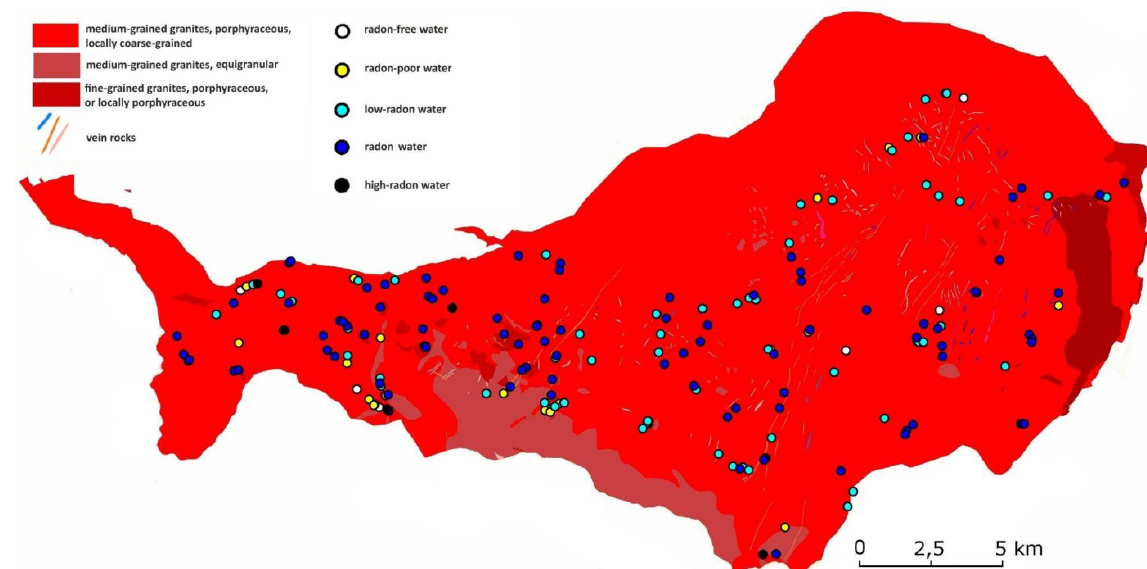
Figure 2. The Karkonosze granites. Groundwater sampling sites plotted together with the types of collected water by 222 Rn content according to Przylibski’s classification [2].